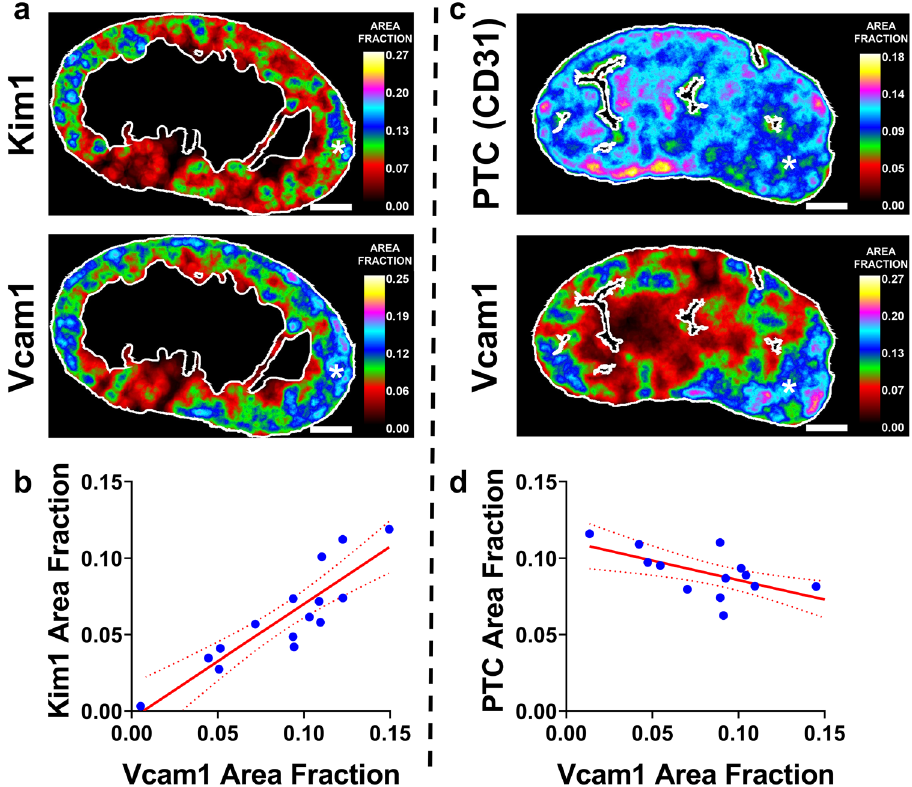
Figure 5. U-Net segmentations show a strong positive correlation between markers of failed repair and a negative correlation between failed repair and peritubular capillary density. The cortex and OSOM in coronal sections of injured kidneys were analyzed from mice sacrificed 14 d after ischemic kidney injury. ( a ) Kim1 and Vcam1 were co-stained and each channel was segmented using the U-Net models developed in Fig. 2. Heat maps of the segmentation area fraction of representative sections are shown (all sections are shown in Supplementary Fig. S15). Note areas with high Kim1 density correlate with high Vcam1 density (*). Scale bar = 1 mm. ( b ) The relationship between the segmentation area fractions of Vcam1 and Kim1 for each section is shown and demonstrates a tight correlation (Pearson r = 0.883, p < 0.0001). ( c ) Representative heatmaps for Vcam1 and peritubular capillaries (PTC) are shown (all sections are shown in Supplementary Fig. S16). Note that areas of Vcam1 staining tend to have lower PTC density (*). Scale bar = 1 mm. ( d ) The relationship between the segmentation area fractions of Vcam1 and PTCs for each section is shown and demonstrates a tight correlation (Pearson r = −0.67, p = 0.006). Dotted lines represent 95% confidence range for linear regression ( b,d